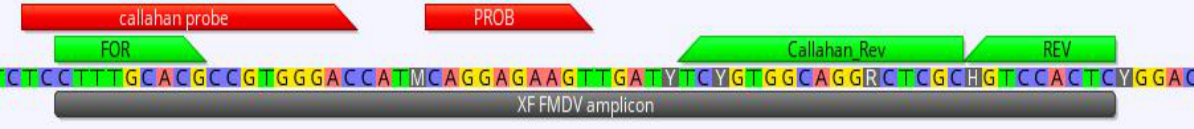
Figure 2. Location of the primers and probes of the newly developed FMD assay. The location of the primer/probe of the gold standard FMD reference assay is shown to provide context. The consensus is generated from the alignment of 1044 FMDV full genome sequences to accession number AF189157.